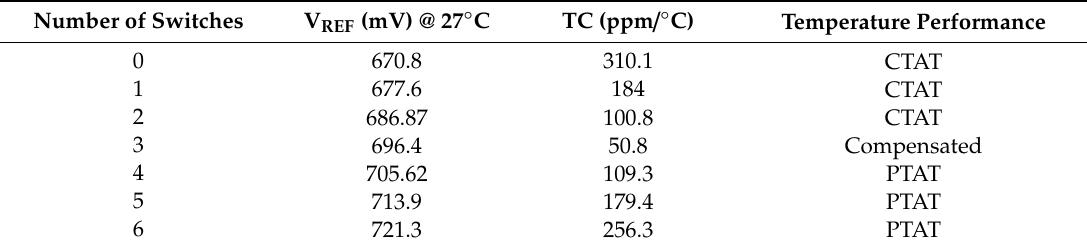
Figure 13. Simulated V REF as a function of temperature and the number of switches at a high level. Table 5. V REF and TC as a function of the number of switches at a high level.